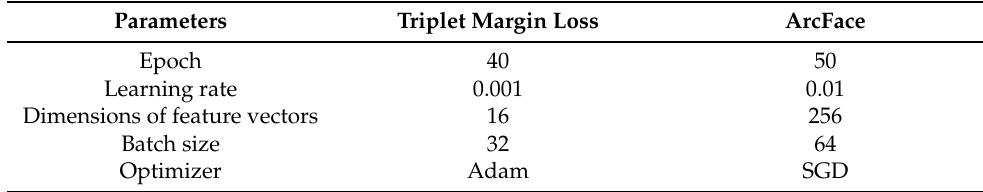
Table 2. Parameters of deep metric